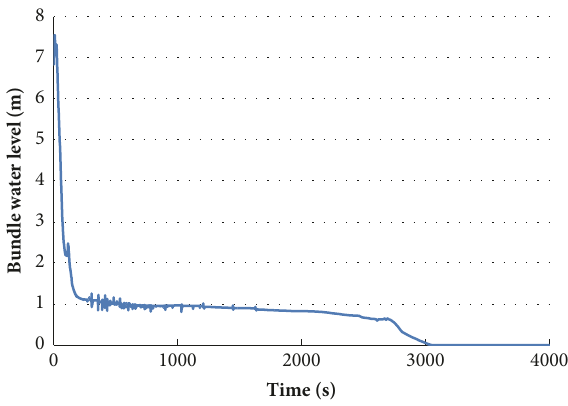
Figure 5: Water level in the RPV.